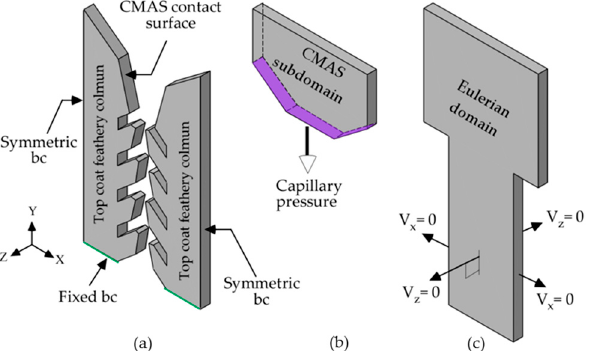
Figure 7. Boundary conditions for the fluid-solid interaction model (FSI): ( a ) boundary conditions for the rigid top coat model; ( b ) applied capillary pressure at the bottom surface of the molten CMAS; and ( c ) velocity boundary condition for the Eulerian domain.